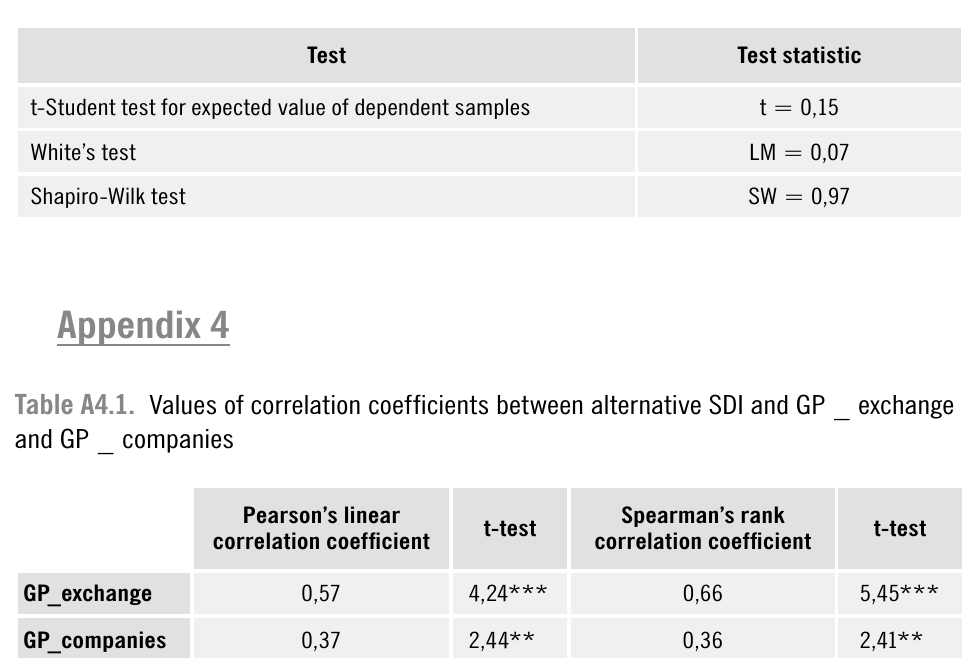
Table A3.3. Results of OLS assumptions diagnostics test for alternative SDI against GP _ all